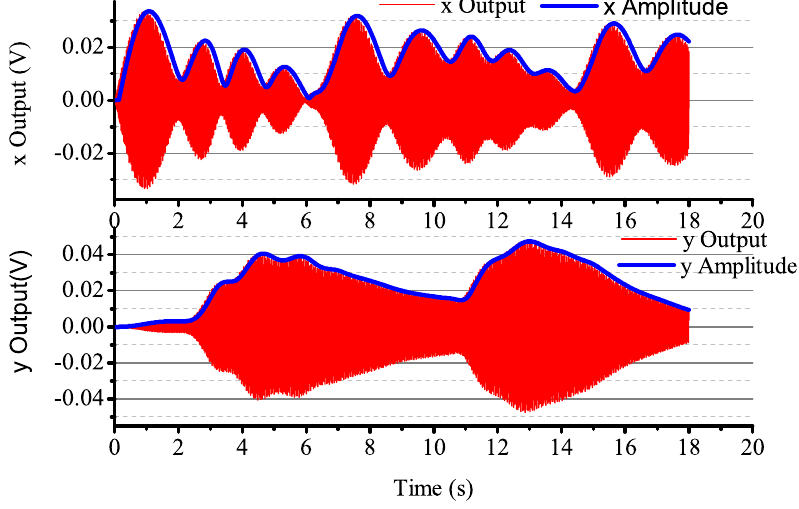
Figure 18. The gyro’s output with non-control in Ω is the sine